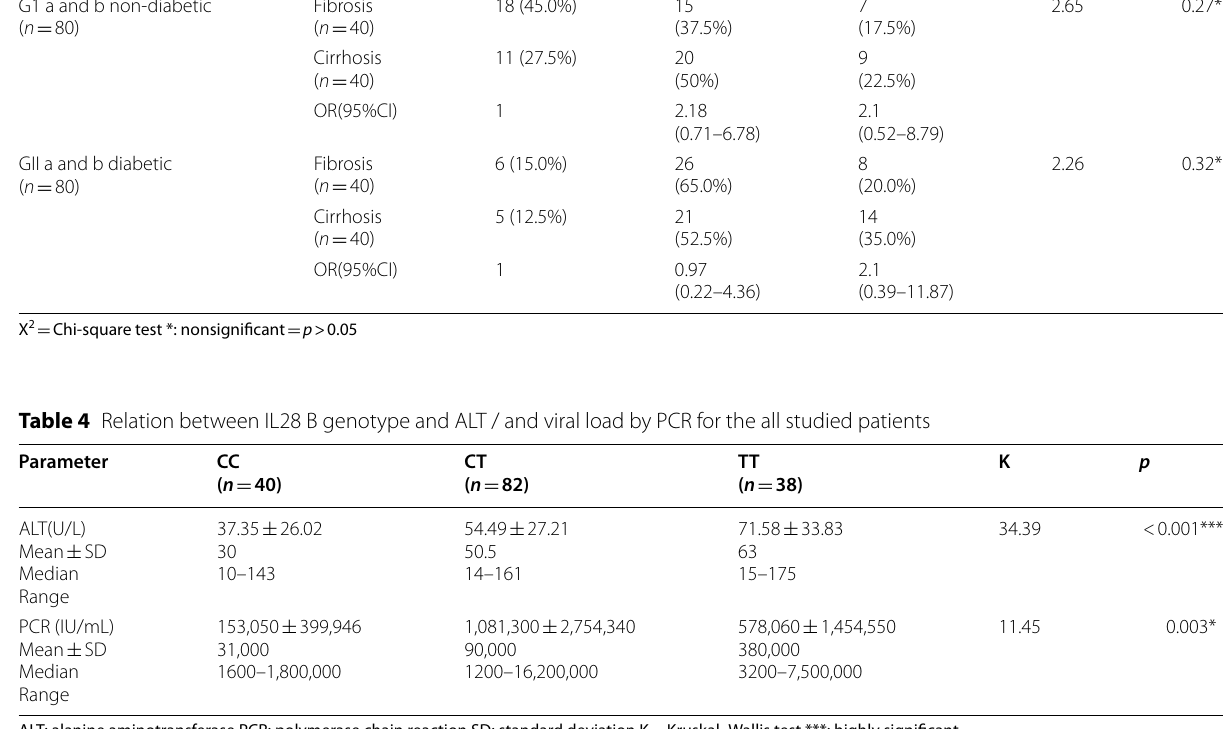
Kruskal–Wallis test ***: highly significant = 0.002 CC versus TT p < 0.001. CT versus TT p 0.004). LSD of PCR between genotypes: = = =